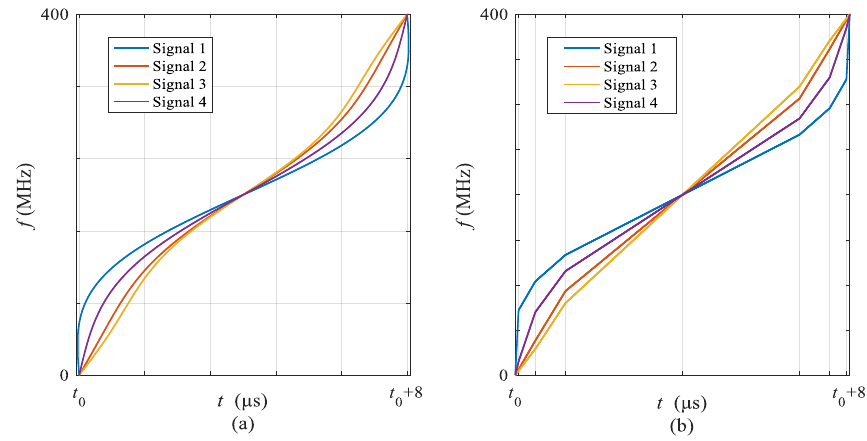
Figure 7. Time-frequency structure ( a ) NLFM signals, ( b ) piecewise chirp signals.